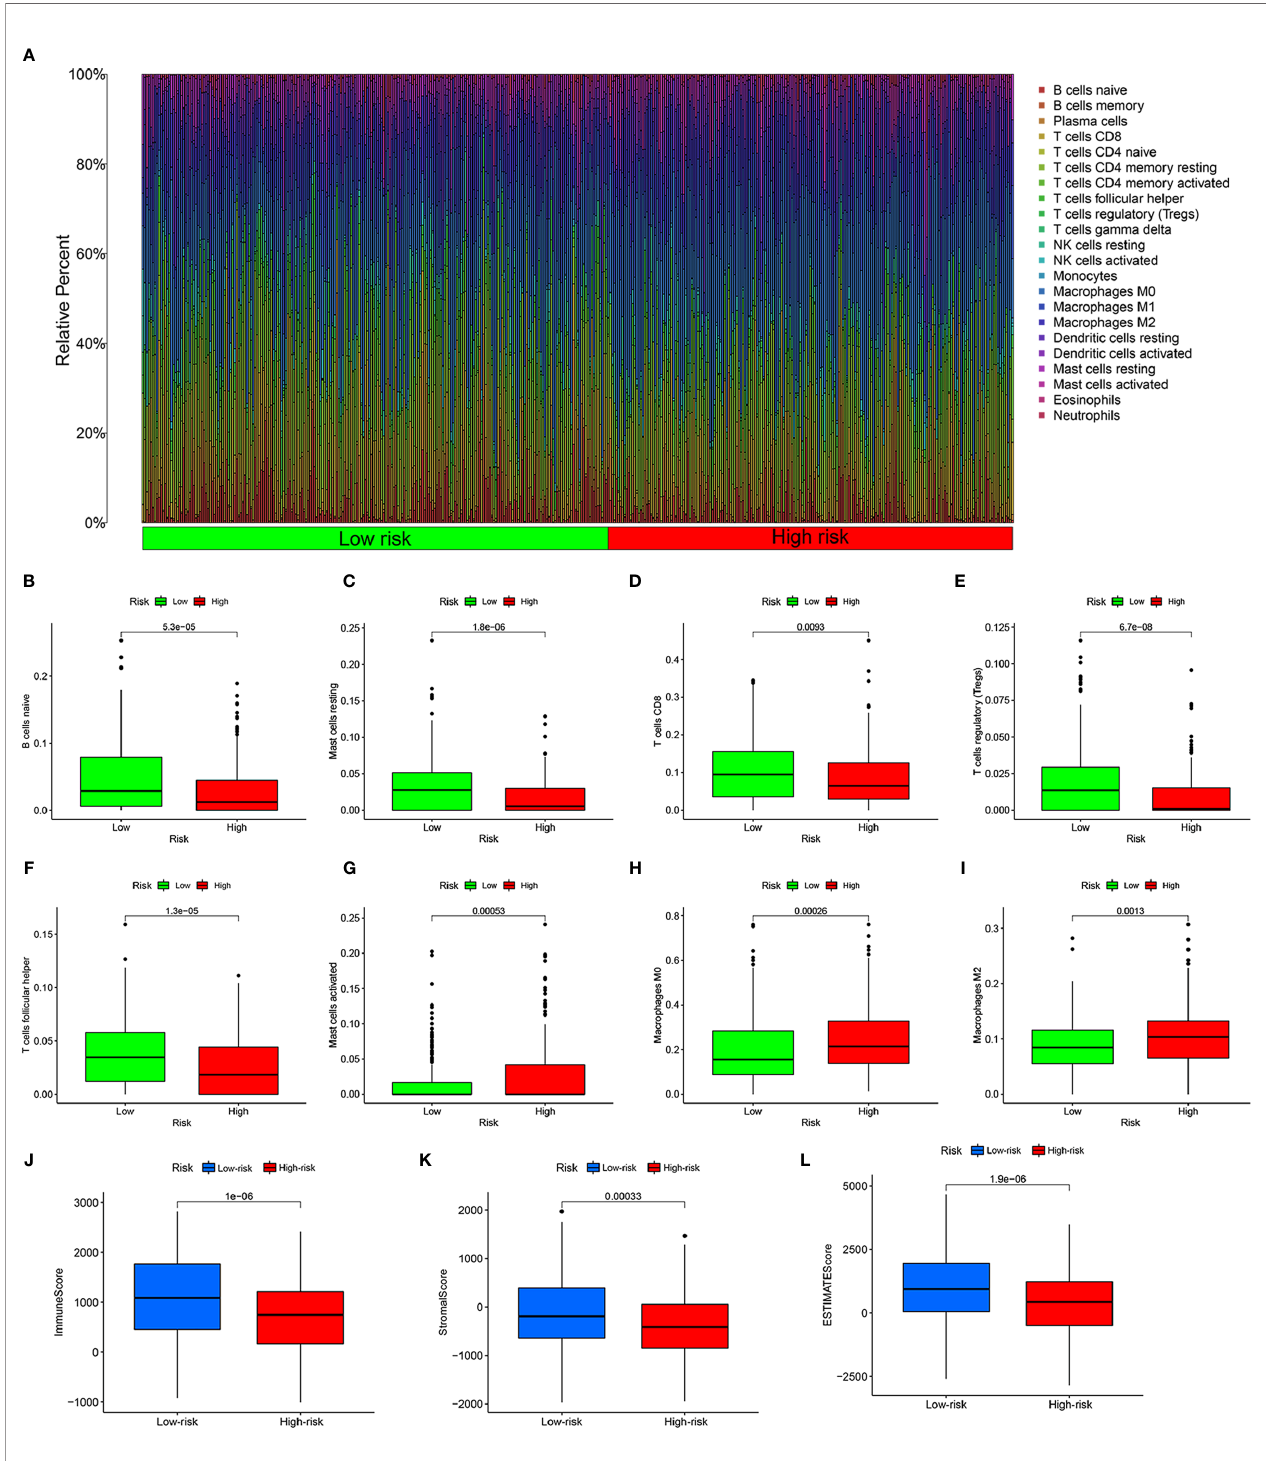
FIGURE 5 | Estimation of the immune microenvironment. (A) Relative percentage of 22 types of tumor-in fi ltrating immune cells from the CIRBERSORT. Greater in fi ltration of B cells naïve (B) , resting mast cells (C) , CD8 T cells (D) , regulatory T cells (E) , and follicular helper T cells (F) in the low-risk group, and more in fi ltrating activated mast cells (G) , M0 macrophages (H) , and M2 macrophages (I) in the high-risk group. Higher immune score (J) , stromal score (K) , and ESTIMATE score (L) calculated by ESTIMATE in the low-risk